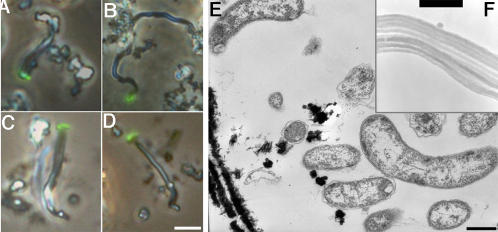
Micrographs of strain PV-1.A–D, Light micrographs showing cells attached at the end of the filaments; the cells have been stained with Syto and composite epifluoresence and phase contrast images produced to show the cells stained green. The bar = 5 µm. E TEM image of the cells, note the Gram-negative type cell wall and the fibers of Fe-oxides in the lower left corner. The bar = 0.5 µm. F. A HRTEM image of the Fe-oxide filament showing its composition as a bundle of conjoined fibers of Fe-oxide. The bar = 0.63 µm.